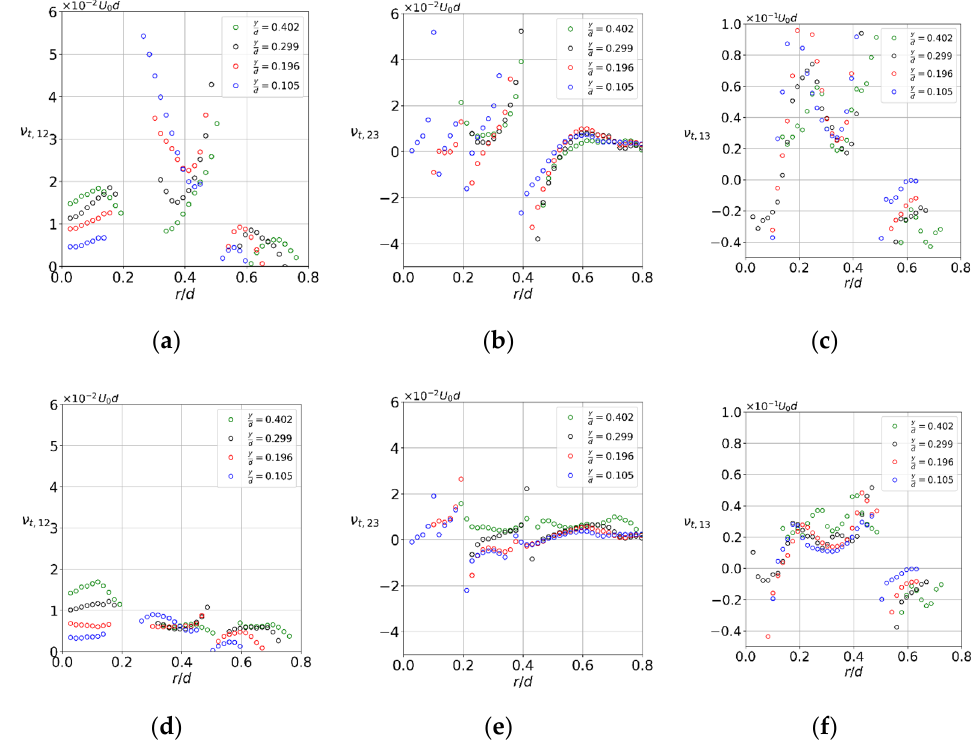
Figure 18. Turbulent viscosity coefficients for ( a – c ) total and ( d – f ) stochastic turbulent fluctuations for gas turbine swirler.